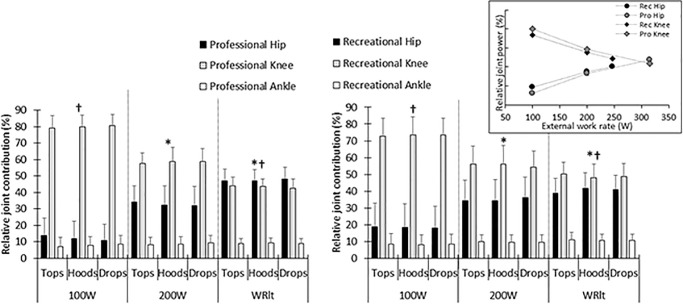
Joint specific power for the hip (black bars), knee (grey bars) and ankle (white bars) joints in the tops, hoods and drops positions for the professional (left panel) and recreational (right panel) cyclists.*indicates a significant difference from previous external work rate, # indicates a significant interaction between external work rate and performance level and † indicates a significant interaction effect between external work rate and handgrip position. Inset plots the hip (circles) and knee (diamonds) joints for both groups as a function of absolute external work rate.